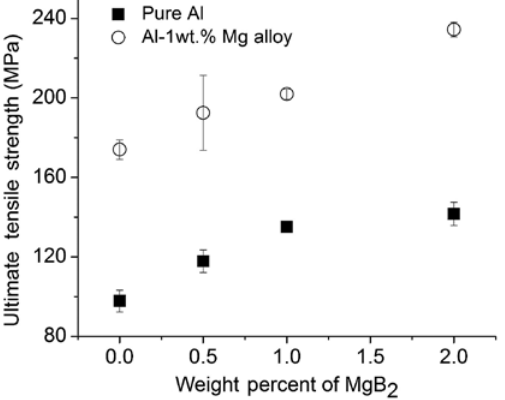
Figure 8: Measured ultimate tensile strength of aluminum wire samples as a function of the amount of diboride